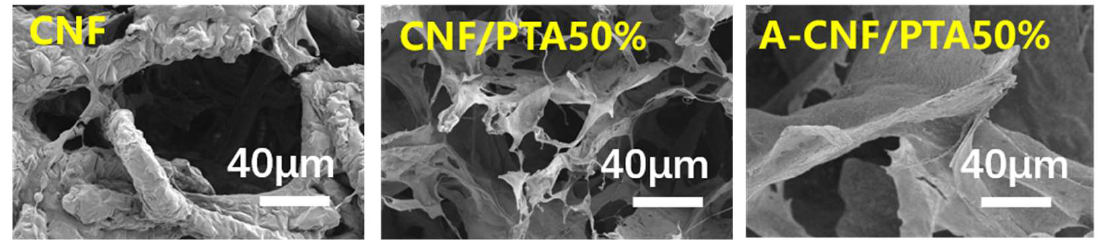
Figure 2. SEM images of the aerogels CNF, CNF/PTA50%, and A-CNF/PTA50%.